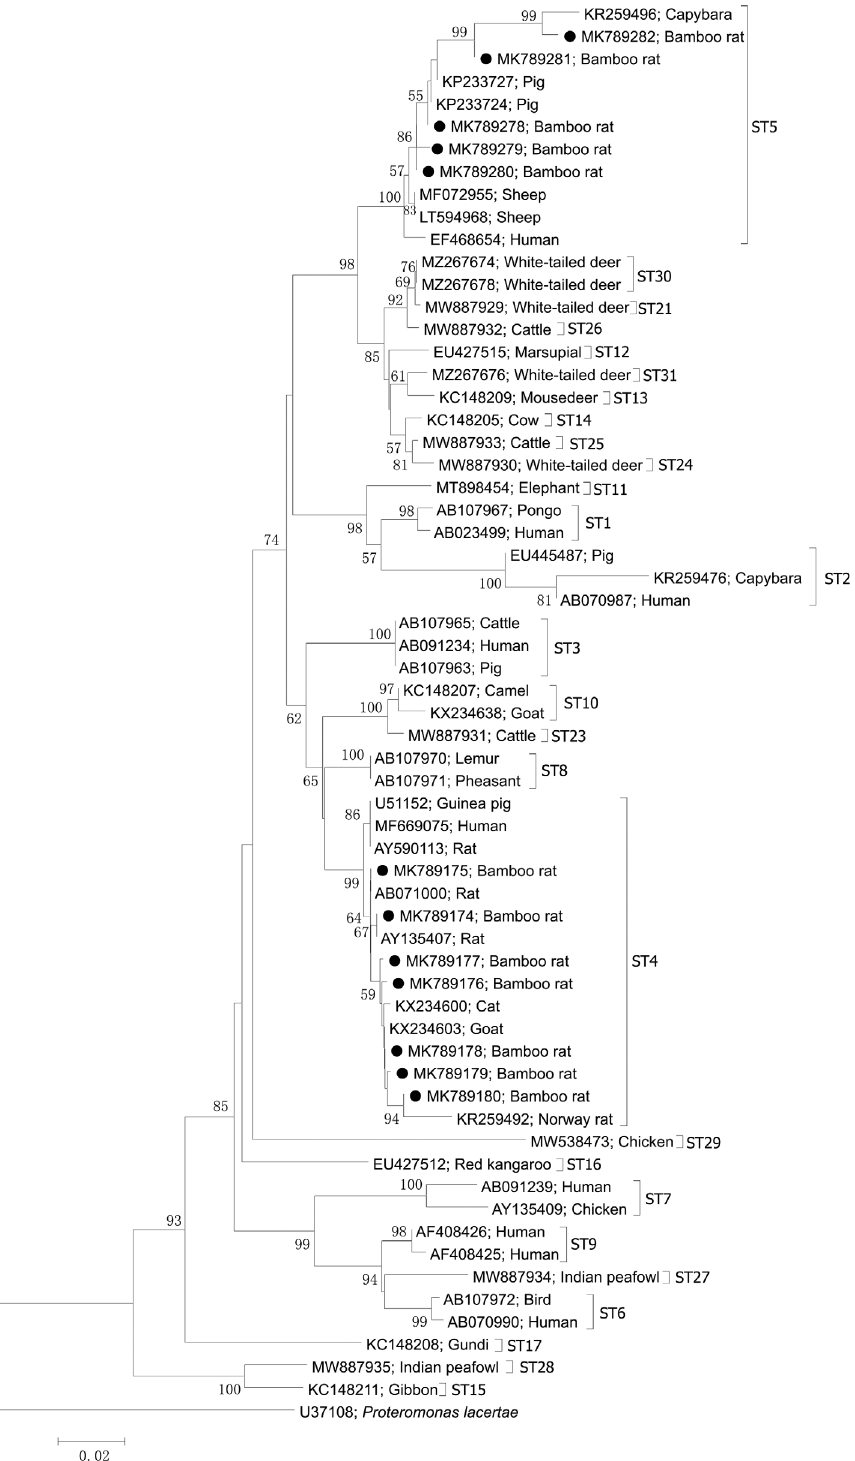
Figure 1. Phylogenetic analysis of Blastocystis subtypes in the present study (black fi lled circles before the accession number) with reference sequence from GenBank based on the SSU rRNA gene fragment by the neighbour-joining method using the Kimura 2-parameter model. Bootstrap values (>50) are indicated at the nodes. Scale bar indicates 0.02 nucleotide substitutions/site. Proteromonas lacertae (U37108) is used as the